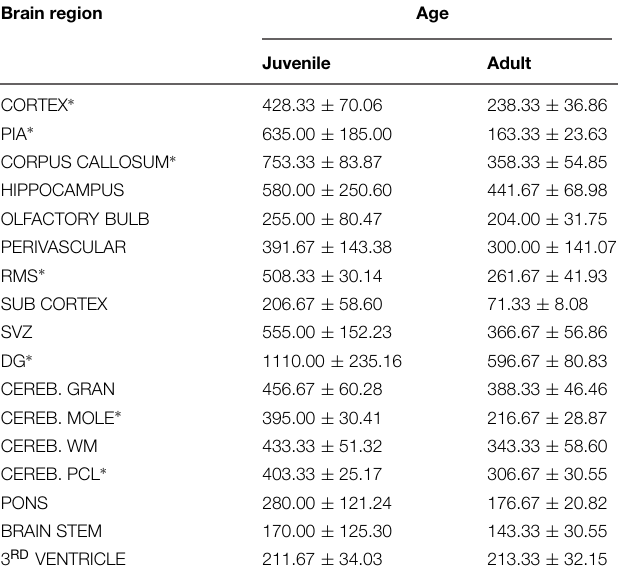
TABLE 2 | Astrocyte counts in different brain